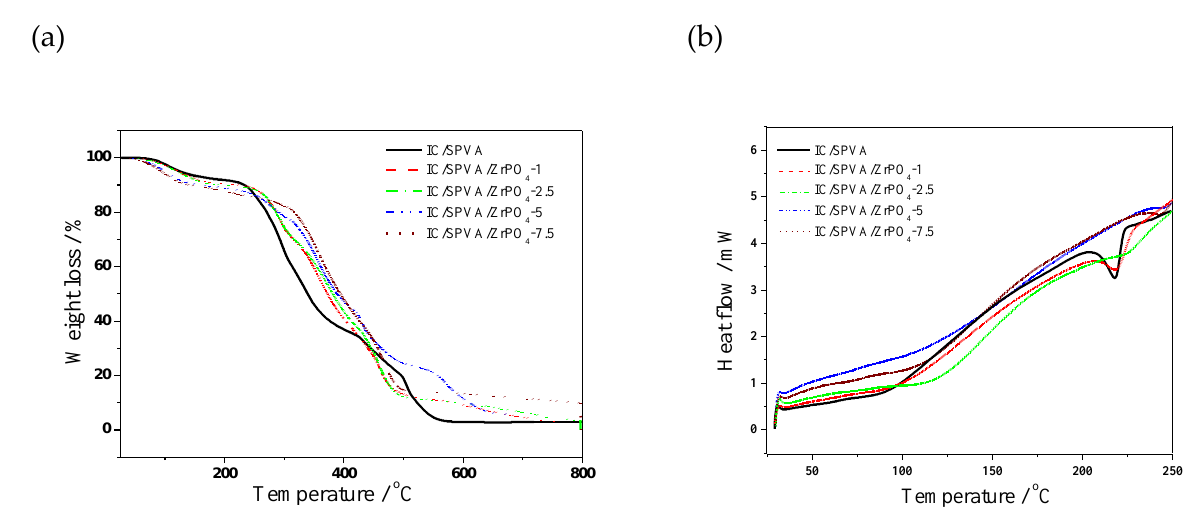
Figure 5. ( a ) TGA and ( b ) DSC curves of ZrPO 4 nanocomposite membranes.